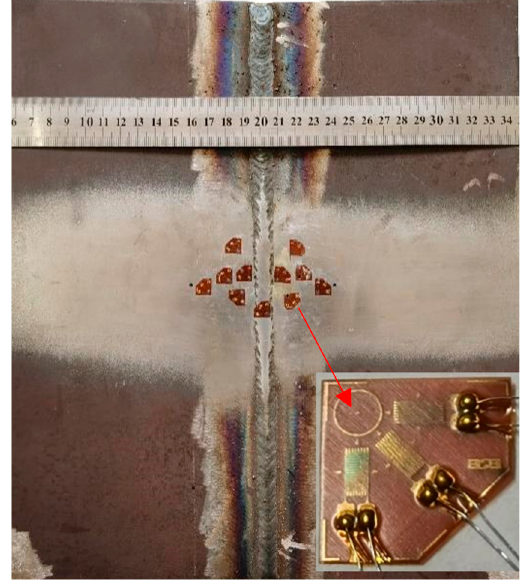
Figure 4. Stress measurement. After the residual stress measurement, the specimen was cut from the center of the welded joint and the micro-hardness of the joint was measured. The measurement points were distributed along a line L1 as shown in Figure